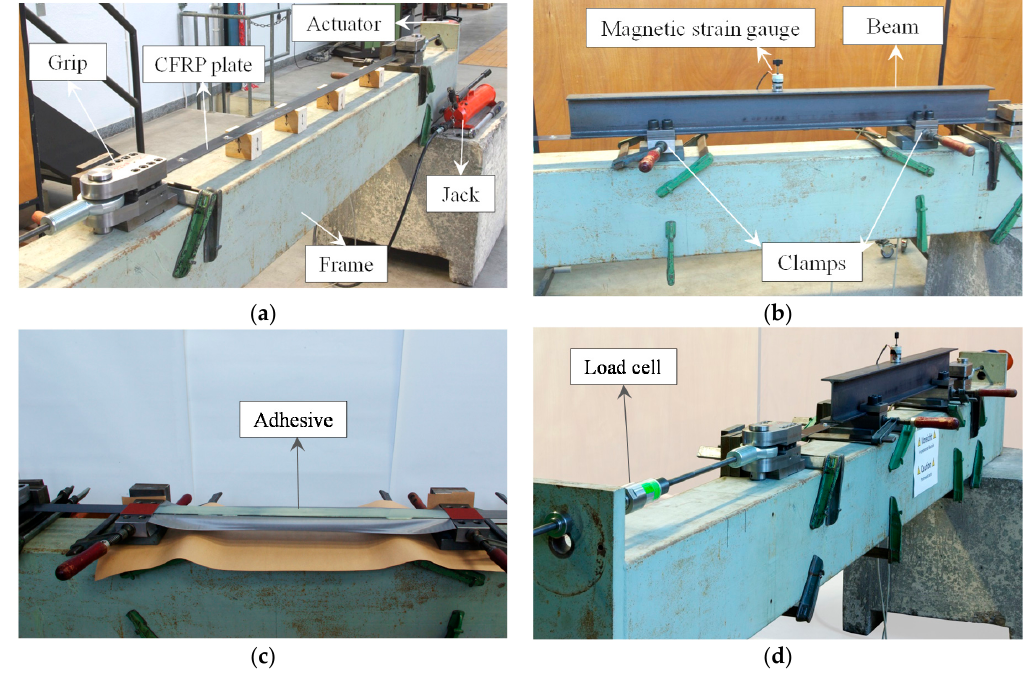
Figure 6. Strengthening set-up. ( a ) A manual hydraulic jack is used to stretch the CFRP plate, ( b ) mechanical clamps are used to fix the plate to the beam in the un-bonded systems, ( c ) in bonded systems, adhesive are applied on top of the CFRP plate and ( d ) the beam is placed on top of the plate for at least 24 h for curing.